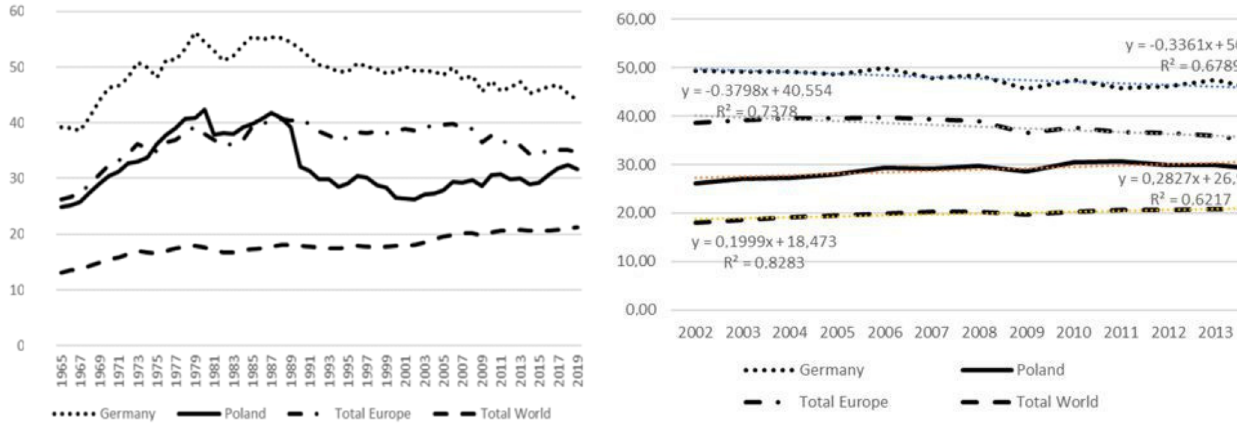
Figure 4. Energy consumption per capita in 2019 in Poland (in MWh), based on [17]. The change in primary consumption in Poland can be described by the equation below. The R-Squared (R 2 ) indicator over 0.5 is acceptable.